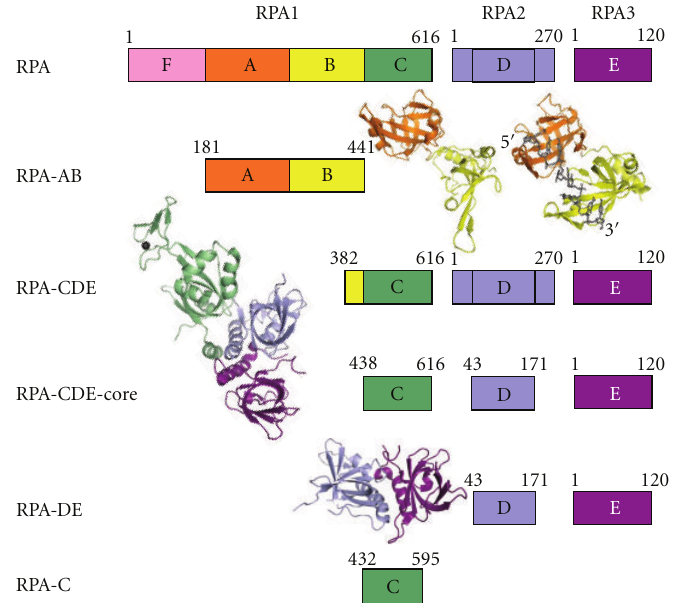
Figure 1: RPA domain structure, constructs used in these studies and their corresponding crystal structures. RPA-AB contains RPA1 181 − 441 . RPA-CDE includes RPA1 382 − 616 and intact RPA2 and RPA3. RPA-CDE-core consists of RPA1 438 − 616 , RPA2 43 − 171 , and intact RPA3. RPA-DE includes RPA2 43 − 171 and intact RPA3. RPA-C is composed of RPA1 432 − 595 with 7 point mutations (V435T, W442Q, V465T, V469T, F523S, F567S, and I571T). Crystal structure representations of RPA-AB apo, RPA-AB + dC 8 , RPA-CDE-core, and RPA-DE are shown next to their domain maps